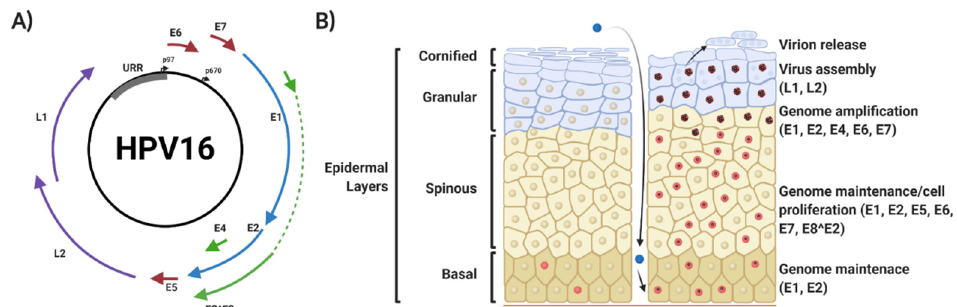
Figure 1. Human papillomavirus (HPV) 16 genome organisation and viral life cycle. ( A ) Organisation of the HPV16 genome, showing the relative position of the early viral genes (E1, E2, E4, E5, E6, E7 and E8ˆE2), the late viral genes (L1 and L2) and the upstream regulatory region (URR). The position of the early and late promoter regions is shown. ( B ) Schematic of epithelial architecture and the stages of the viral life cycle, highlighting viral genome expression profile. Details are explained in the text. Red nuclei indicate mitotically active cells. The presence of episomal HPV genomes maintains cells in a mitotically active state upon migration into the spinous layers of the epithelium, where viral amplification and late gene expression occurs. HPV virions are then released in leaky squames that are sloughed o ff the top layers of the epithelia. Figure created using